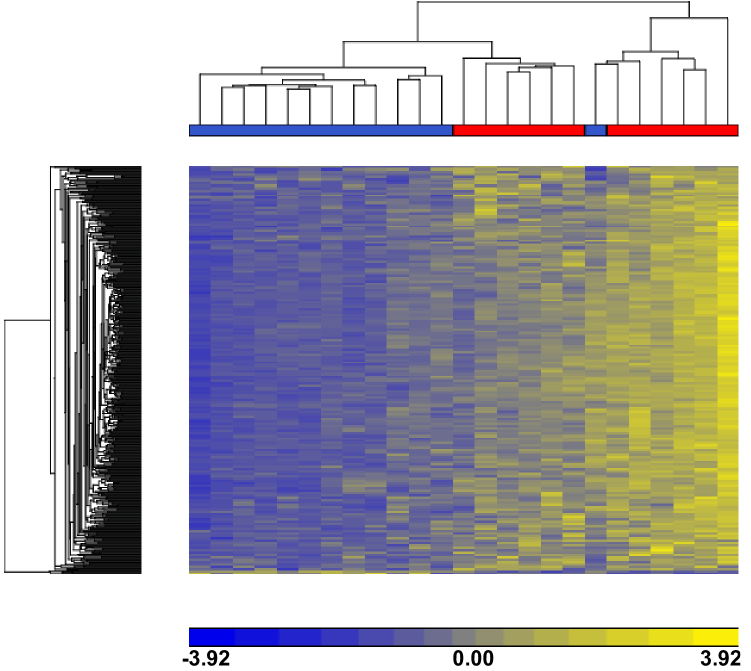
Fig 3. Unsupervised hierarchical clustering of 500 most variable CpG sites derived from samples distinguishes ME/CFS (N = 13) cases and controls (N = 12). 500 DMS above and below mean level are represented by blue and yellow across all cases and were used to cluster cases. As shown above, 12 of 13 ME/CFS cases (blue on color-coded bar above the dendrogram) cluster together (left dendrogram branch) and 12 of the 12 controls (blue color-coded bar) cluster together (right dendrogram branch), resulting in a divergence of these sub-phenotypes.